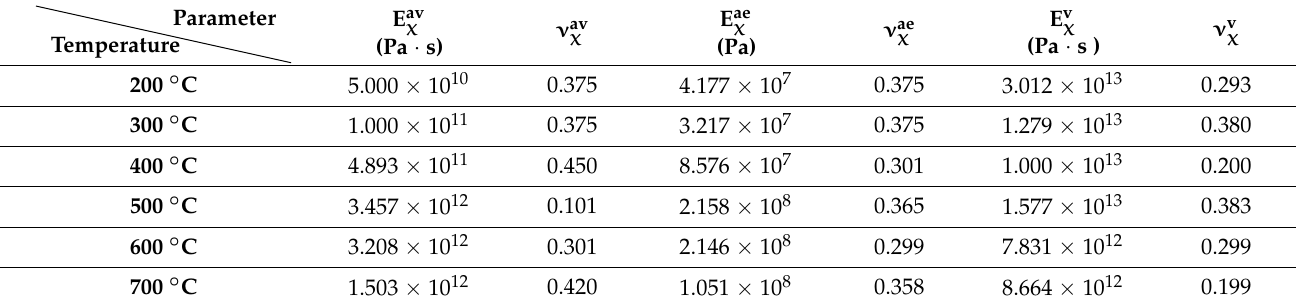
Table 3. Parameters in the Burger’s rheological model for different baking